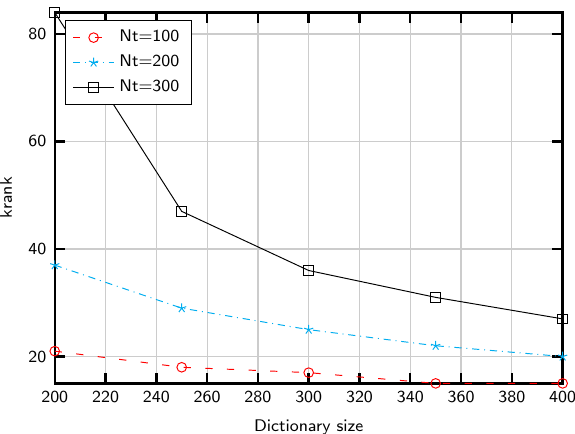
Figure 2. Kruskal rank upper bound for different array and dictionary